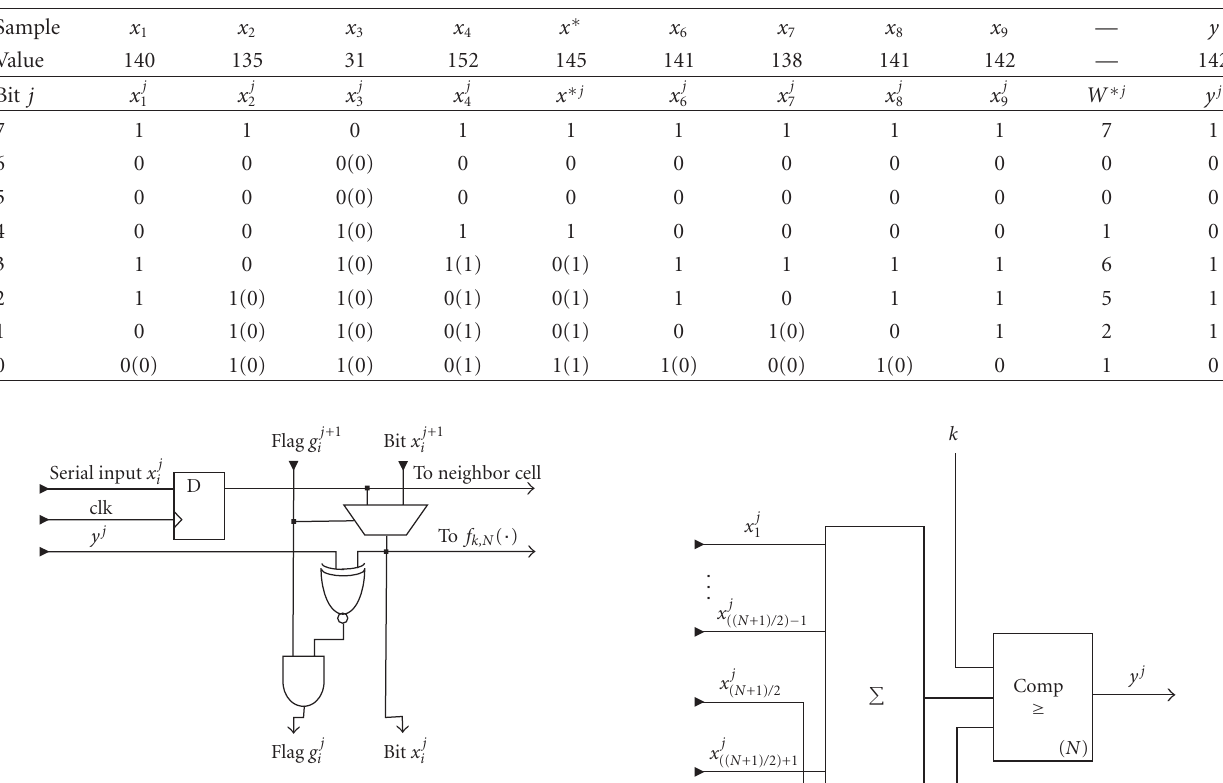
Table 4: LUM-PBF smoothing ( N = 9 and k = 3) realized via the bit-serial approach.